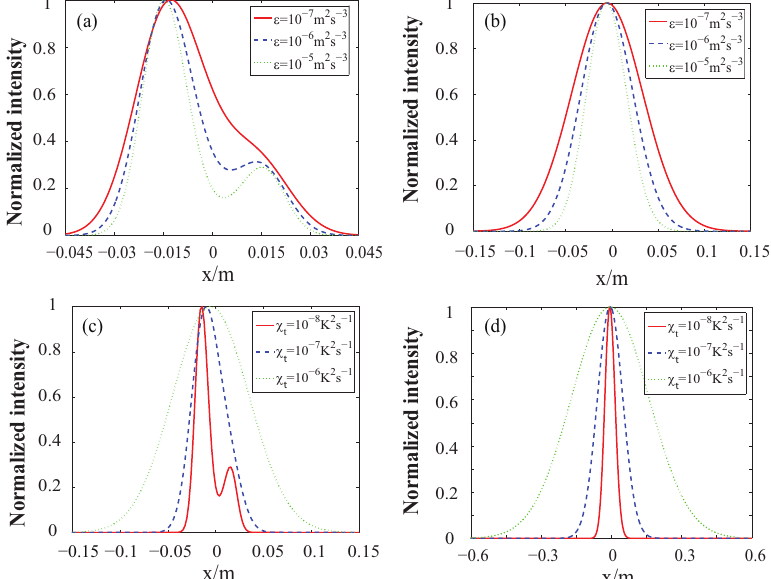
Figure 6. Cross lines ( y = 0) of the normalized average intensity of the OAHGSM vortex beam passing through anisotropic oceanic turbulence with different ε and χ t at z = 300 m ( a ), z = 800 m ( b ), z = 300 m ( c ), and z = 800 m ( d